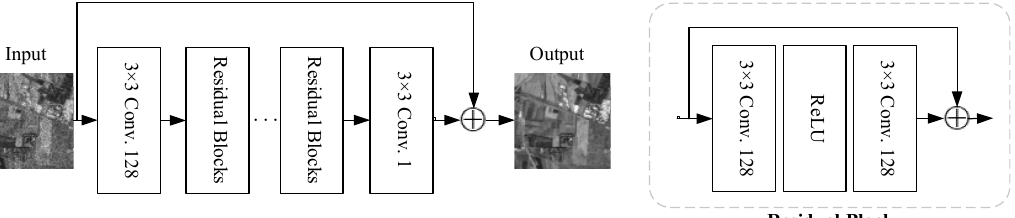
Figure 4. Architecture of the distorted image restoration model. It includes 16 residual blocks. 3 × 3 Conv. indicates the convolutional kernel with the size of 3 × 3. The number after the dot represents the output channel of each convolutional layer.